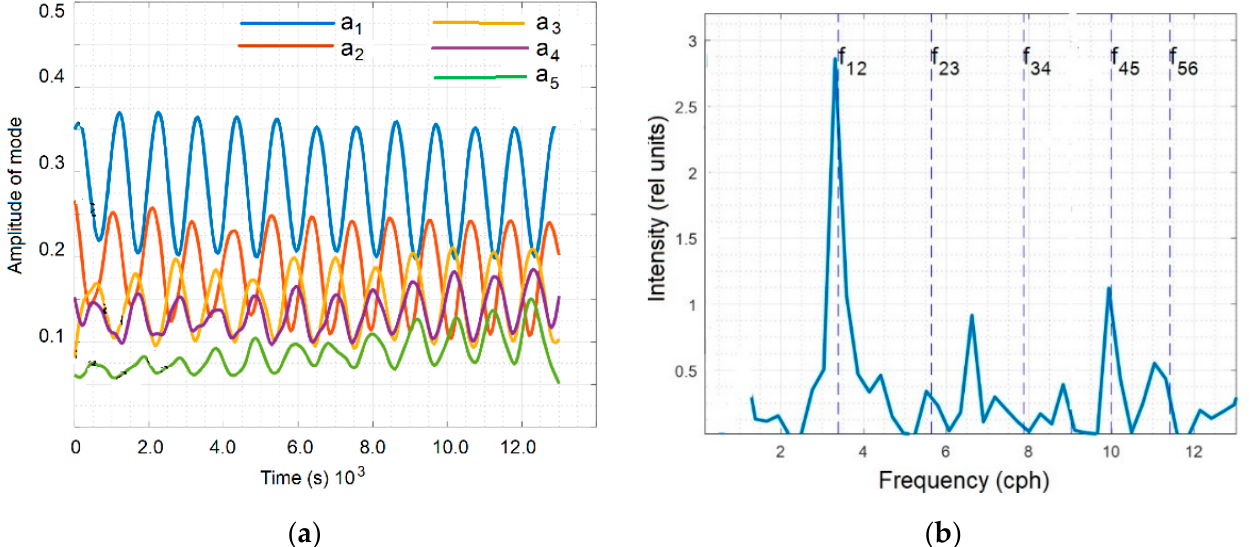
Figure 2. ( a ) Temporal dependence of modal amplitudes; ( b ) spectrum of fluctuations (12) of sound intensity.